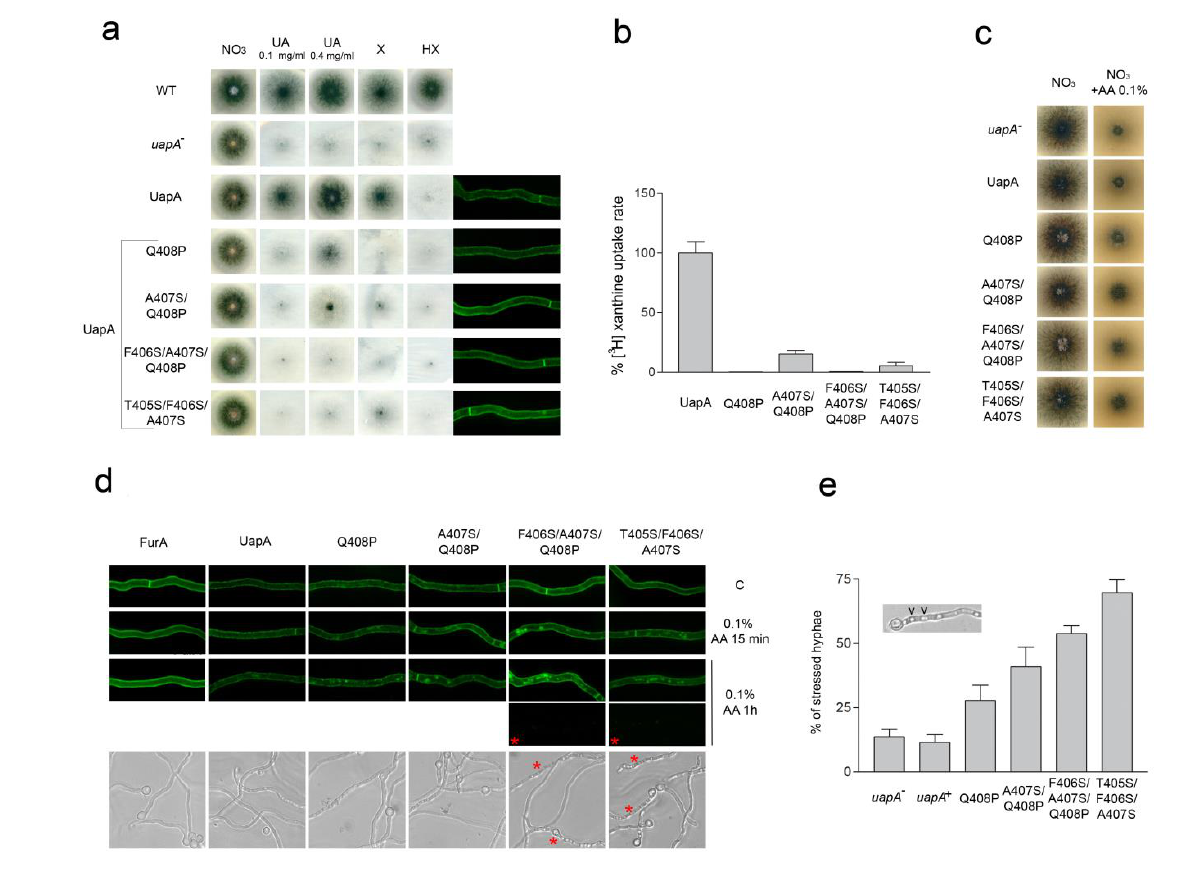
FIGURE 2: Specific residues within the NAT signature motif are critical for UapA function and specificity. (a) Growth tests, on standard MM, of isogenic strains expressing wild-type (UapA) or mutant UapA versions (Q408P, A407S/Q408P, T405S/F406S/A407S and F406S/A407S/Q408P), expressed in a genetic background genetically lacking other major purine transporters (i.e. ΔuapC ΔazgA ). A strain lacking a functional UapA ( uapA - ) and a standard wild-type A. nidulans strain (WT) are also included in the test as controls. The test depicts growth on 10mM sodium nitrate (NO 3 ) or 0.1 mg/ml uric acid (UA), xanthine (X), hypoxanthine (HX), after 48 h at 37°C. A 4-fold higher concentration of UA (0.4 mg/ml) was also used in order to distinguish UapA mutants with highly reduced affinity for substrates (Q408P, A407S/Q408P) from mutants with an apparent total loss of transport activity (T405S/F406S/A407S and F406S/A407S/Q408P). Subcellular localization of wild-type or mutant UapA-GFP versions, as revealed by in vivo epifluorescence microscopy, is also shown at the right side of the panel. Notice that in all cases UapA-GFP is stably localized in the plasma membrane and the septa of A. nidulans hyphae. For details of sample preparation see Material and methods. (b) Comparative UapA-mediated uptake rates of radiolabeled 3 H-xanthine in strains ex- pressing wild-type (UapA) or mutant versions (Q408P, A407S/Q408P, T405S/F406S/A407S and F406S/A407S/Q408P) of UapA-GFP. Results are averages of three measurements for each concentration point. SD was < 20%. (c) Growth tests, at 37°C, on standard MM supplement- ed with 10 mM sodium nitrate (NO 3 ) as nitrogen source in the absence or presence of 0.1% L-ascorbate (AA) of isogenic strains lacking UapA ( uapA - ), or expressing wild-type (UapA) or mutant UapA versions (Q408P, A407S/Q408P, T405S/F406S/A407S and F406S/A407S/Q408P). (d) Upper panel : In vivo epifluorescence microscopy following the effect of L-ascorbate (0.1% AA) on UapA-GFP or FurA-GFP subcellular localization. Notice that after 15 min addition of AA clear endocytic turnover of UapA-GFP (i.e. appearance of cyto- plasmic structures corresponding to vacuoles; Gournas et al., 2010) is observed in all UapA mutants, but not in wild-type UapA or FurA. Vacuolar turnover is more evident after 1 h of AA in the triple mutants T405S/F406S/A407S and especially F406S/A407S/Q408P, where more and larger vacuoles appear. Notice that after 1 h of AA, moderate vacuolar turnover is also evident in the wild-type UapA, but not in FurA. Noticeably also, 1 h in AA triggers “loss” of GFP fluorescence in a significant fraction (> 50%) of hyphae in in the triple mutants T405S/F406S/A407S and F406S/A407S/Q408P (lowest black boxes marked with a red asterisk). The same effect, albeit significantly re- duced, is also seen in A407S/Q408P (36%) and Q408P (22%), while in the wild-type UapA-GFP or FurA-GFP fluorescence loss is < 10% (not shown). Lower panel : L-ascorbate (1% AA for 1 h) triggers differential hypervacuolarization and reduction of hyphal width (i.e. cell stress) in UapA mutants and controls. Stressed hyphae are marked with a red asterisk. (e) Quantification of the effect of L-ascorbate on hyphal morphology, as recorded for 100 hyphae, of each strain analyzed. In all cases, hypervacuolarization and reduction of the width of hyphae was associated with loss of fluorescence (not shown). The results depicted in the graph confirm the apparent cytotoxicity of L-ascorbate in the triple mutants T405S/F406S/A407S and F406S/A407S/Q408P, where 50-70% of hyphae seem stressed, followed by progressively low- er effects on A407S/Q408P (40%), Q408P (27%) and wt UapA